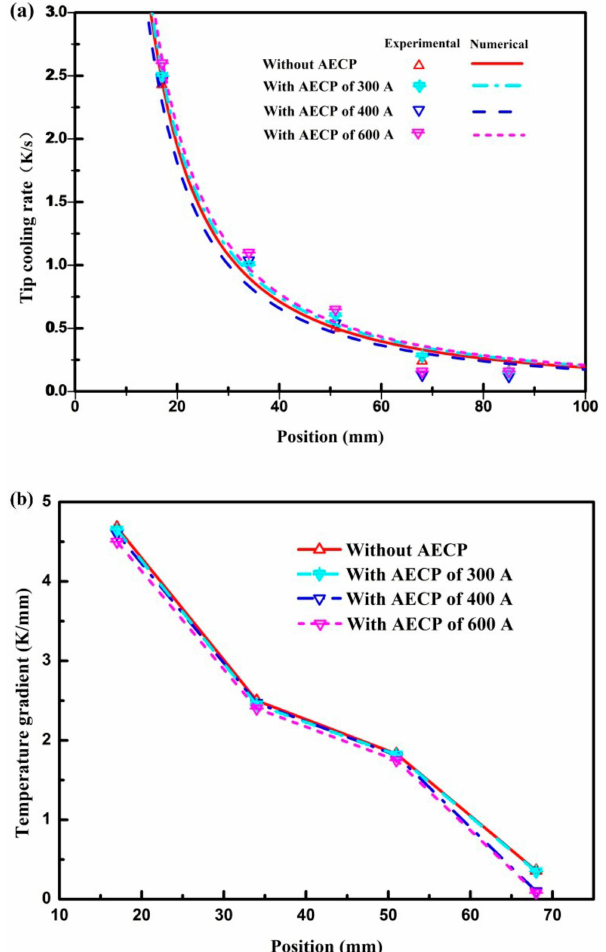
Figure 3. Cooling rate ( a ) and temperature gradient ( b ) as a function of position from metal / mold